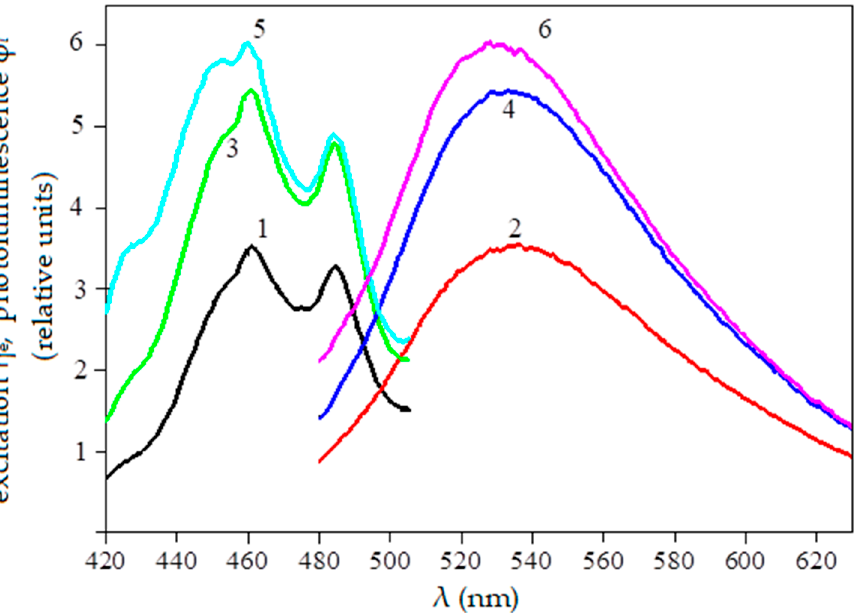
Figure 1. The spectral characteristics of unscarified and scarified galega seeds: 1,2—uncarified, 3,4—scarified once, 5,6—scarified twice